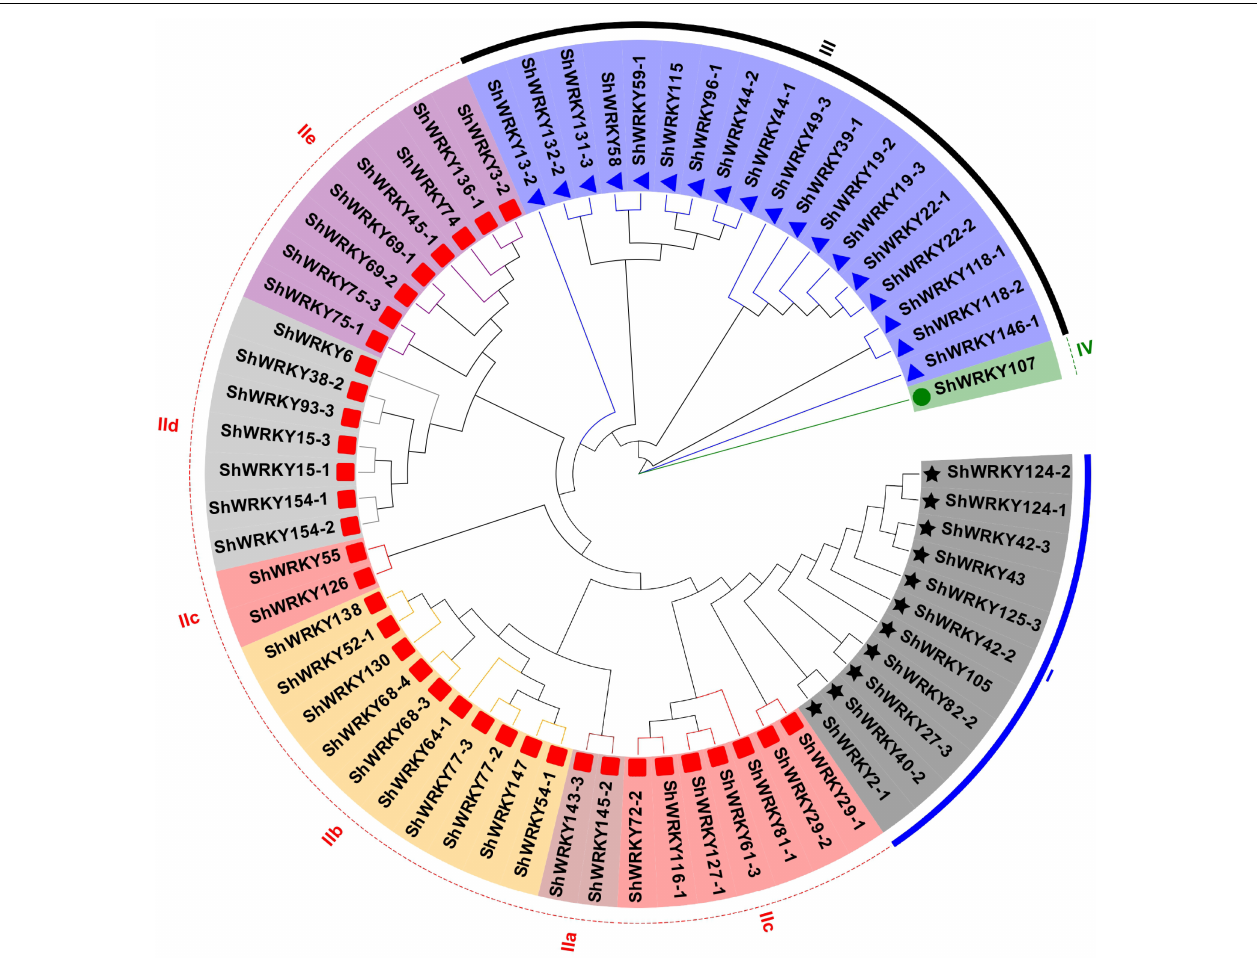
FIGURE 1 | Phylogenetic tree of ShWRKYs . The unrooted NJ tree was constructed based on the WRKY domains from Saccharum spp. hybrid R570 using MEGA7.0 with bootstraps of 1,000 replicates. Group and subgroup names are on the outer ring and are depicted in different colors. Black stars, red boxes, blue triangles, and green circles represent different ShWRKY groups I, II, III, and IV,